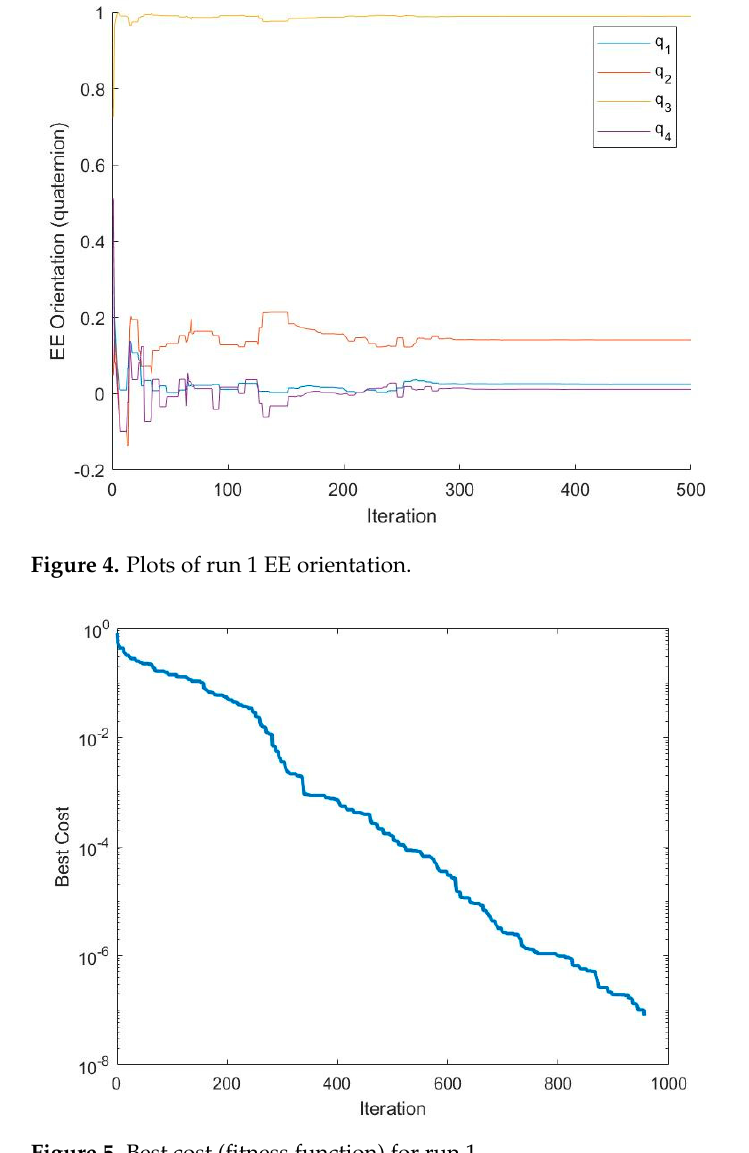
Figure 5. Best cost ( fi tness function) for run 1.